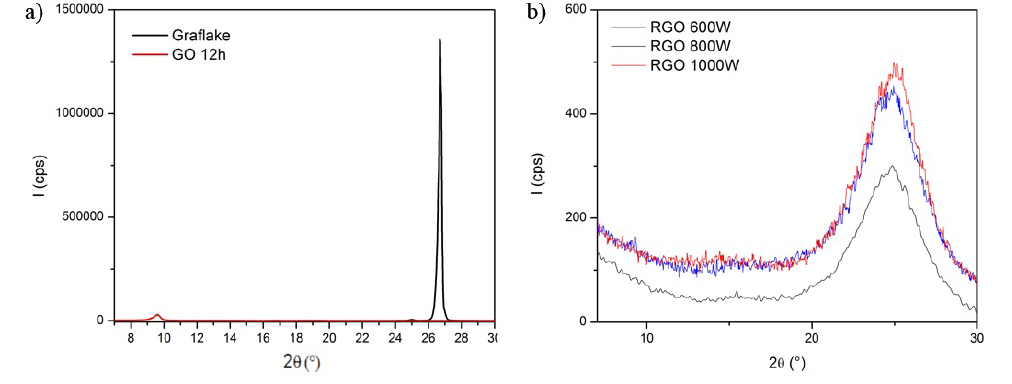
Figure 2. X-ray diffractograms of (a) graphite as received and GO; (b) RGO produced with different microwave reduction time and power parameters. Table 1. Final temperature and heat capacity.